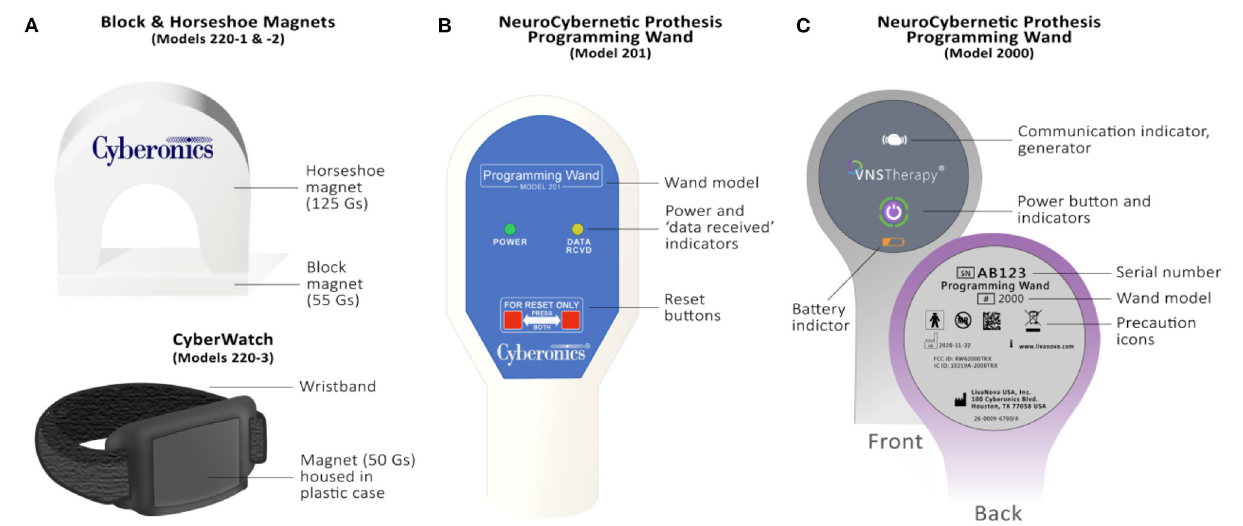
FIGURE 3 | Overview of the VNS Therapy System’s patient magnets and Programming Wands. (A) Legacy block (Model 220-1) & horseshoe (Model 220-2) magnets (top) and watch-style (Model 220-3) magnet (bottom). Guass (Gs), or magnetic flux density is provided for each magnet. (B) M201 Programming Wand. Light indicators on the front signify normal, successful communication (yellow DATA/RCVD light) and a good battery level (green POWER light). Compatible with the M250 “Motion Tablet” Programmer (not shown). The M201 Wand is turned on by pressing two red “RESET” buttons simultaneously. (C) Programming Wand M2000. The Wand’s power button signifies whether it is powered on (two green lights below power button), connected to the M3000 Programmer (four green lights around power button), or is updating (green lights rotate around power button, v1.1 + ). Icons on the front of the Wand also signify communication with the generator (white flashing generator icon) and battery status (orange battery indicator if low). The back of the M2000 Wand features a serial number that registers on the M3000 Programmer for identification